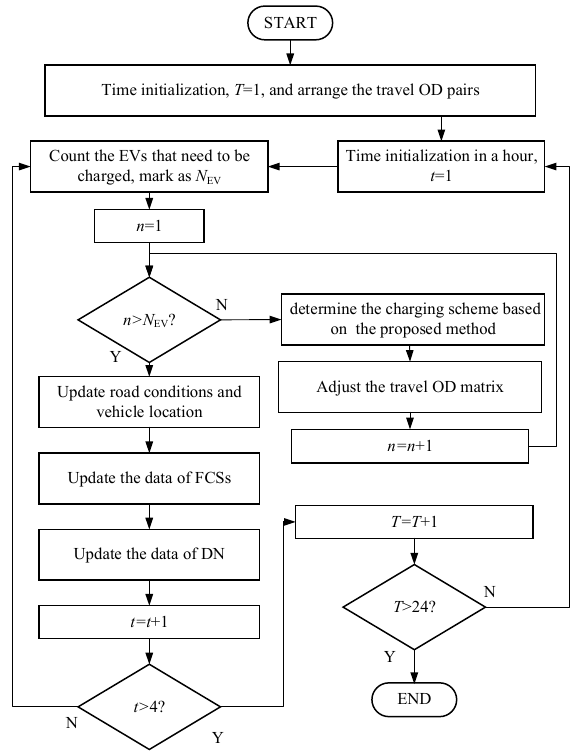
Figure 5. Flow chart of guidance strategy.